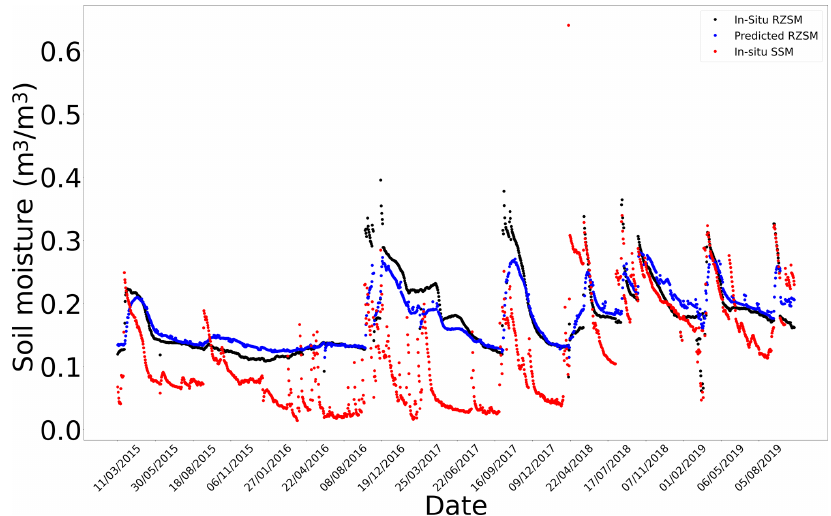
Figure G10. In situ SSM, in situ RZSM, and predicted RZSM series at station P12 (Tunisia) with model ANN_SSM_NDVI_EVAP-EFF-